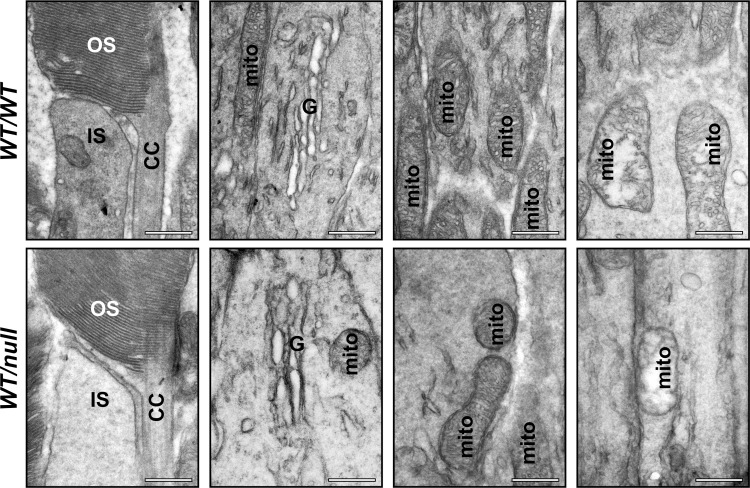
Chmnull/WT show normal ultrastructure of the inner segment, outer segment and connecting cilium.Eyes from 6-month-old heterozygous null female mice (Chmnull/WT) were processed for transmission electron microscopy. High magnification examination of longitudinal sections through the eye cup revealed no abnormalities of the outer segment structure (OS) or connecting cilium (CC) or the Golgi apparatus (G) or mitochondria (mito) in the inner segment (IS) in the majority of cells. Scale bars: 500nm.